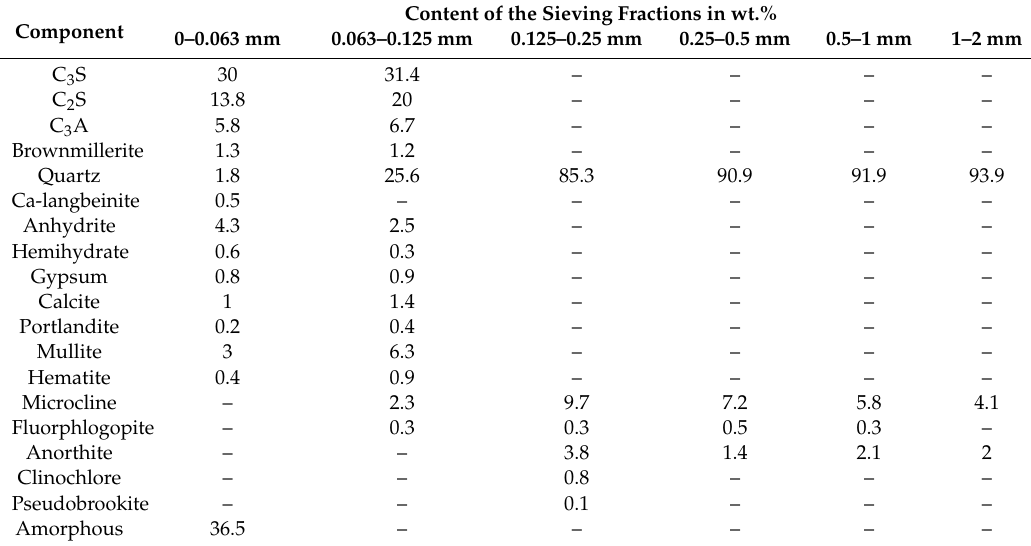
Table 2. Mineralogical analysis of the sieve fractions of the ready-mixed dry concrete.